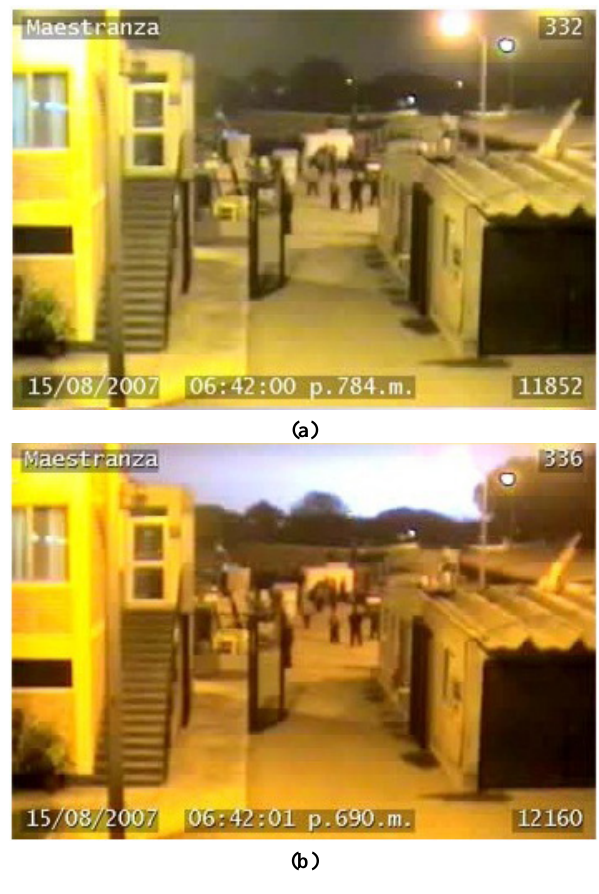
Fig. 6. The EQL, at 06:42:1.690 p.m. LT (a) Before the EQL, at 06:42:0.784 p.m. LT (b) During the EQL, at 06:42:1.690 p.m.